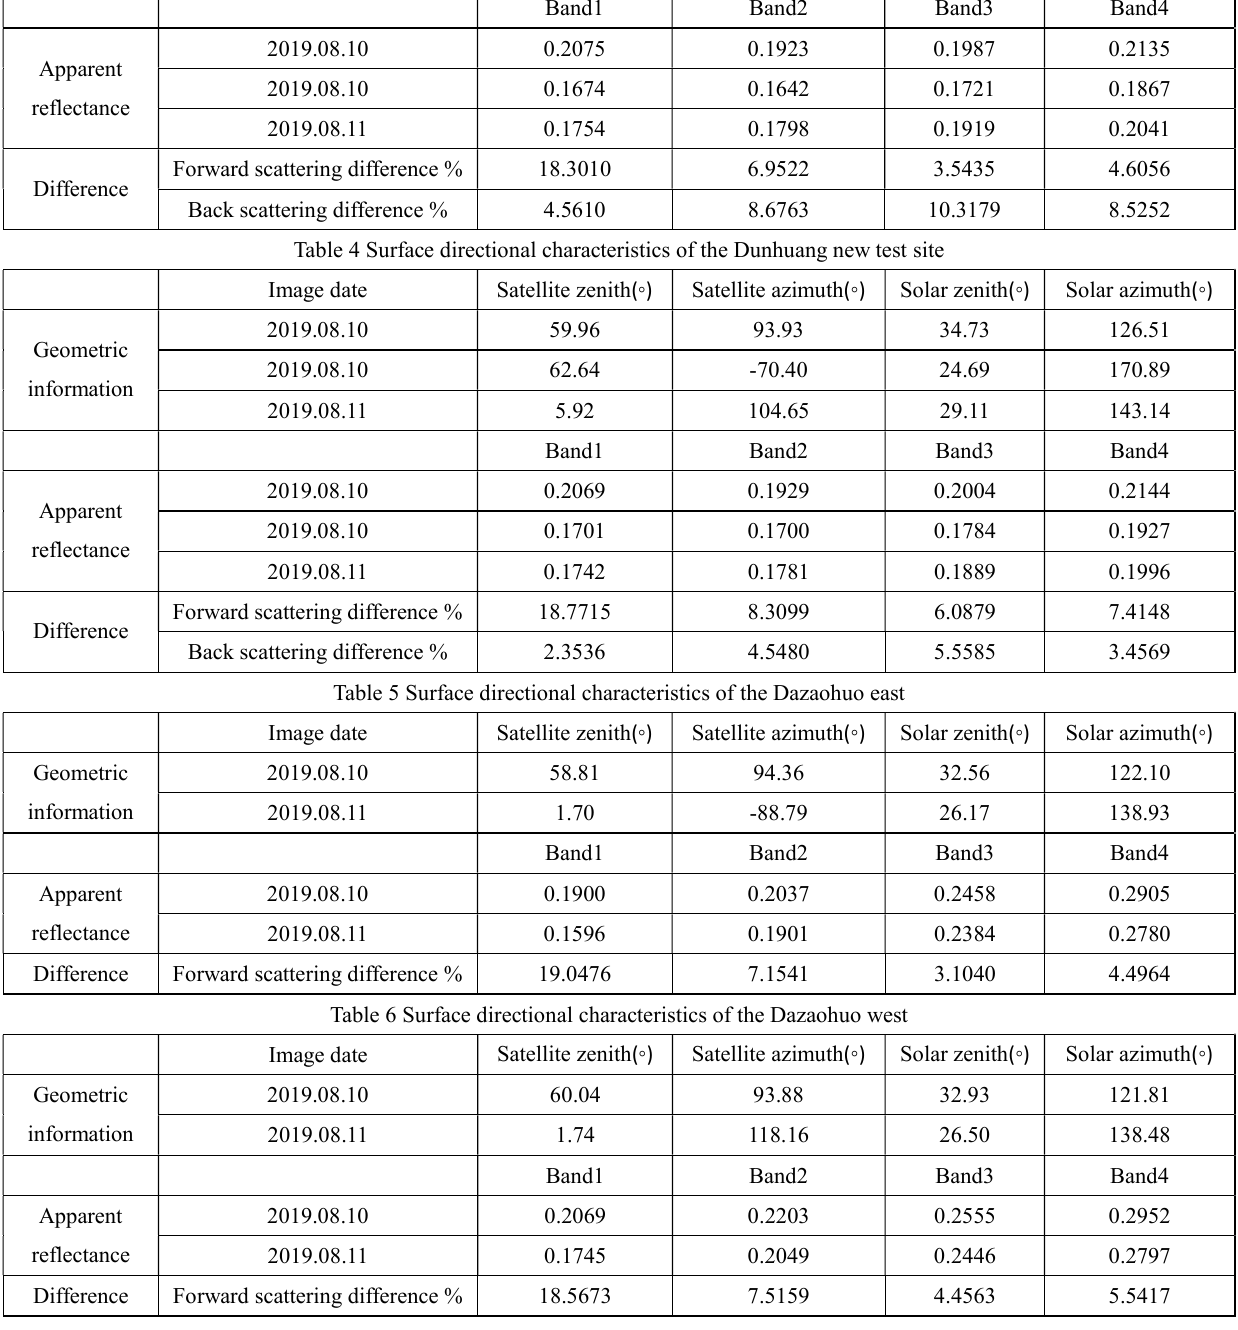
Table 6 Surface directional characteristics of the Dazaohuo